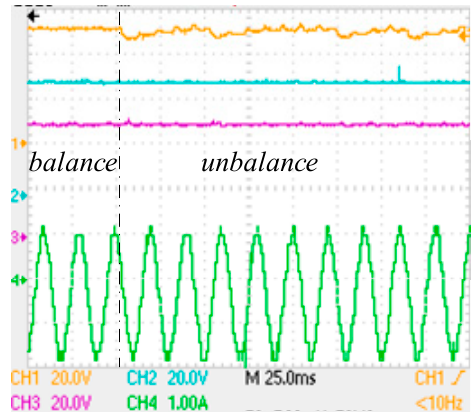
Figure 18. Dynamic performance when SPM applied. (CH1: DC-link voltage of Module 1; CH2: DC-link voltage of Module 2; CH3: DC-link voltage of Module 3; CH4: AC-link current of cascaded modules).